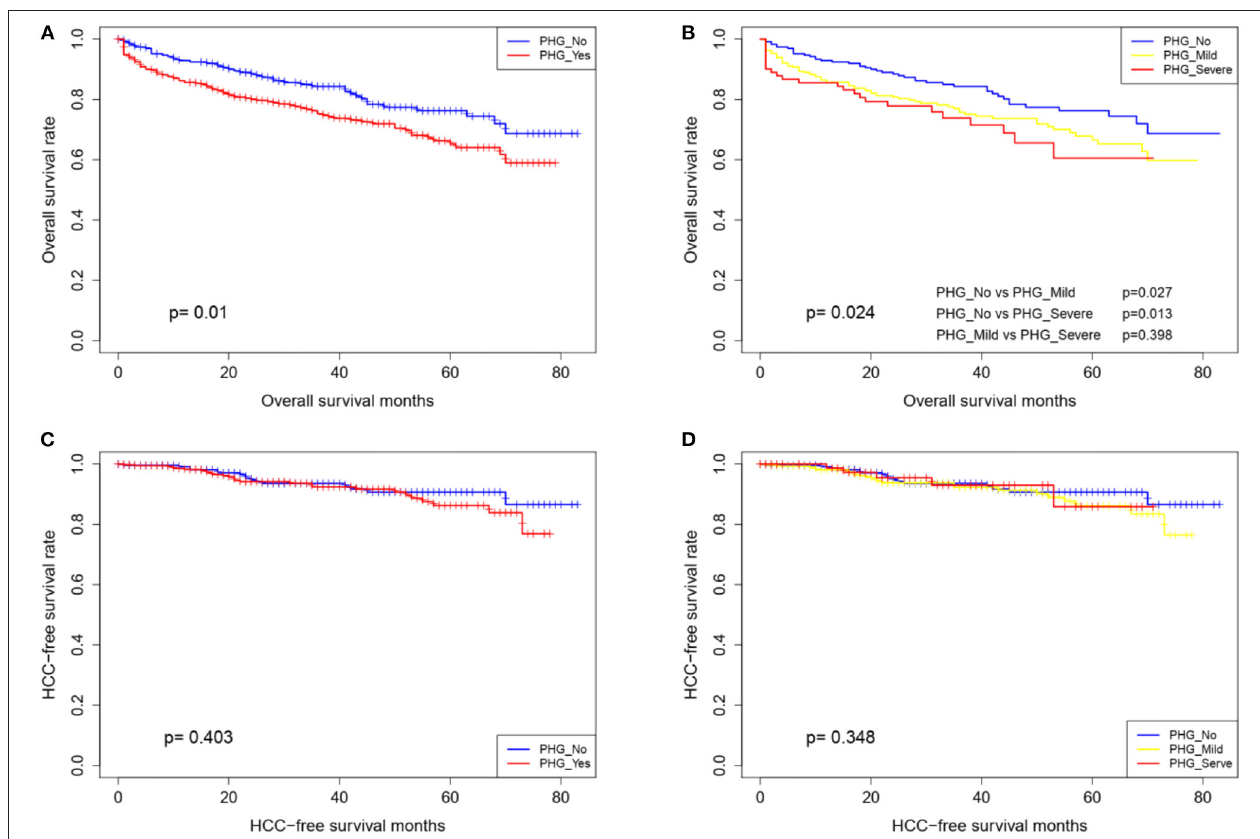
FIGURE 2 | Overall survival and HCC-free survival curves of patients stratified according to the presence (A,C) and grade of PHG (B,D)